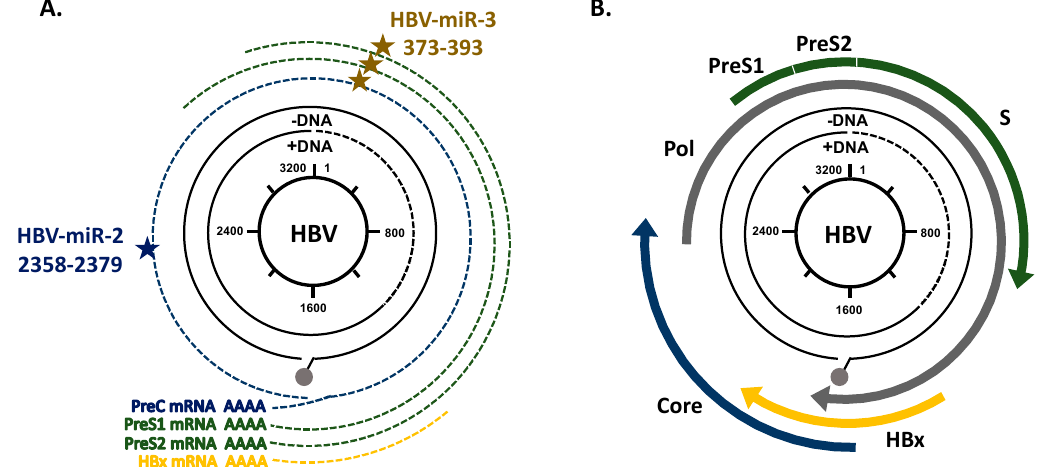
Figure 2. HBV genome organization. ( A ) Different HBV transcripts and positions of HBV sequences encoded for HBV-miR-2 and HBV-miR-3. HBV-miR-2 (blue star) extended from nucleotides 2358 to 2379 of HBV pgRNA. HBV-miR-3 (brown stars) is encoded in the HBV genome at the position 373 to 393 in PreC, PreS1, and PreS2 mRNAs. ( B ) The HBV genome contains four overlapping Open Reading Frames (ORFs): core proteins, HBV polymerase, Surface proteins, and Hepatitis B X protein (HBx).